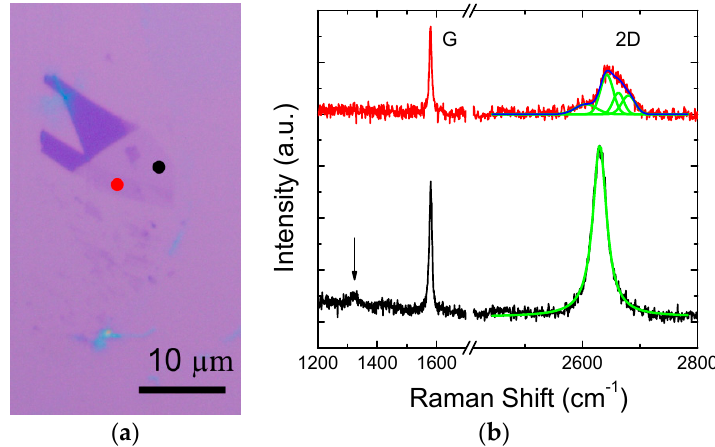
Figure 1. ( a ) Exfoliated graphene flake, black and red dots indicate the monolayer and bilayer regions, respectively; and ( b ) Raman spectra probed at locations marked as two color dots in ( a ). Green lines are the sub-peaks obtained from Lorentzian peak fitting. The arrow indicates the location of D band.